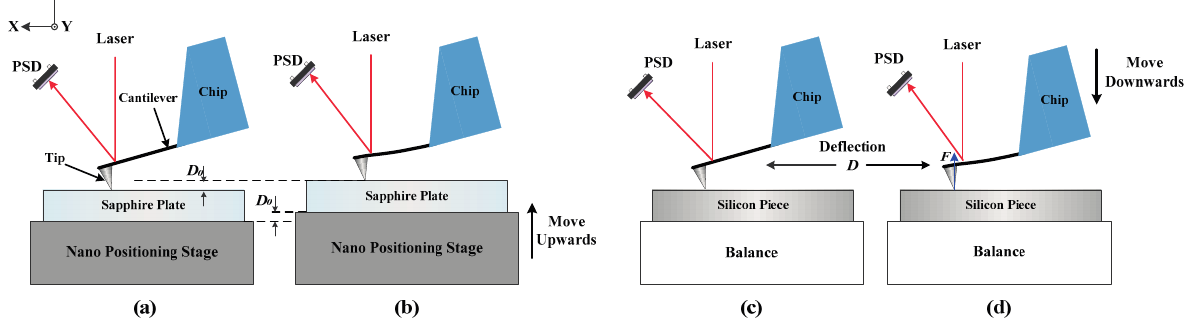
Figure 2. Schematic of the normal spring constant calibration principle. ( a , b ) are the process of calibration of the optical lever sensitivity. ( c , d ) are the process of force